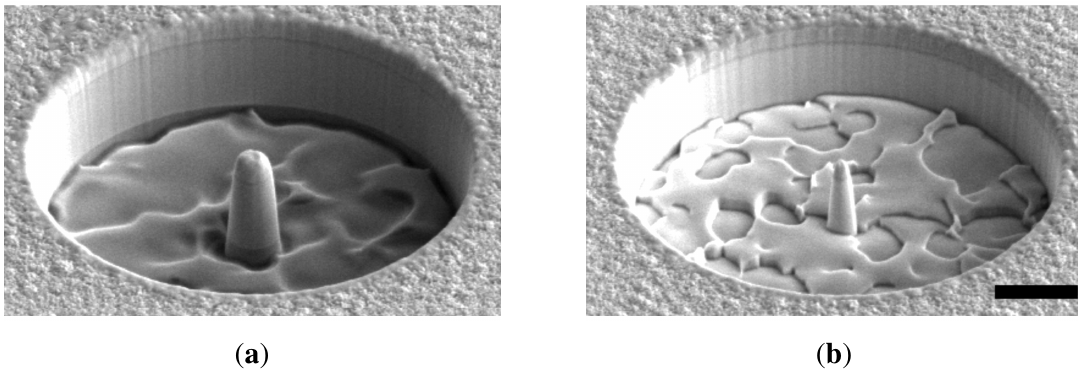
Figure 5. SEM image of ZnO pillars fabricated by focused ion beam on 1800 nm thick sputtered film, using a multilayered metal film as the FIB etching mask. Ga + FIB at 30 keV acceleration energy was used. The scale bar indicates 2 µ m. The ZnO pillar in (a) has a 900-nm diameter on top and is 2.2 µ m tall, being excavated down into the Si substrate, while the pillar in (b) is 1.7 µ m tall and has a diameter on top of 440 nm, resulting in aspect ratios of 2.5 and 3.9,